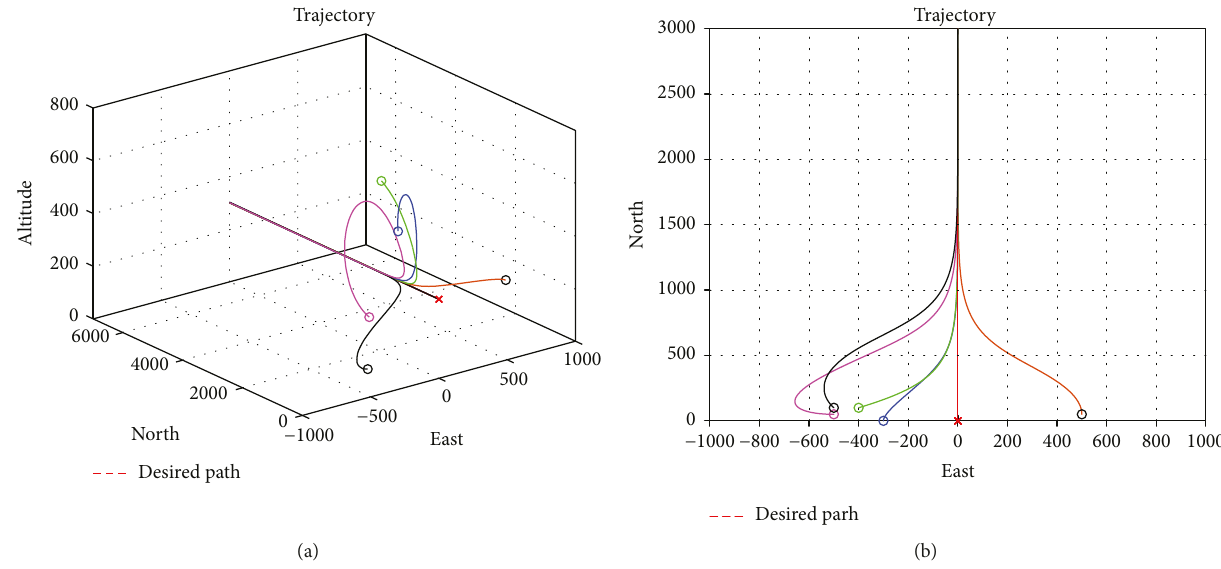
Figure 8: Straight-line path following for various initial conditions. (a) Three-dimensional view, (b) planar view.